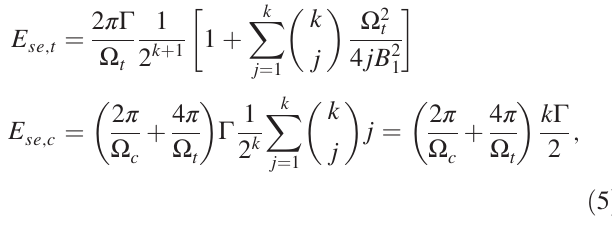
Rydberg state population in the dark state is ð Ω 2 t = 4 jB 2 1 Þ